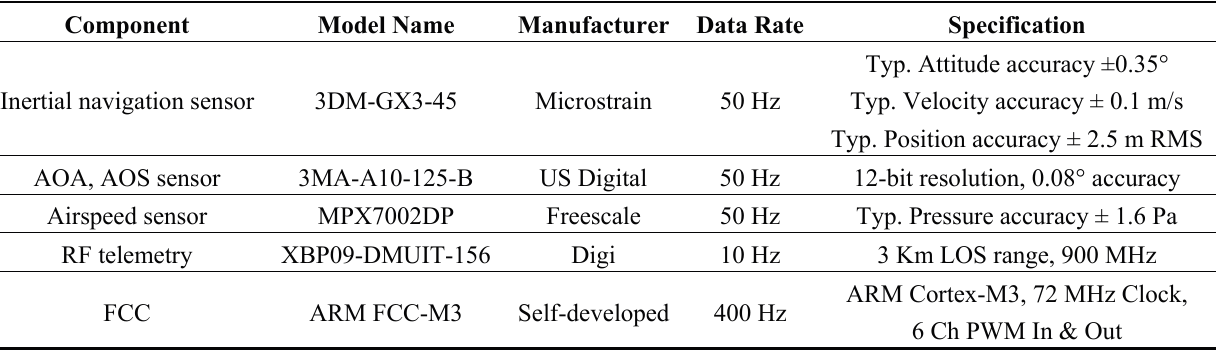
Table 1. Sensors and avionics